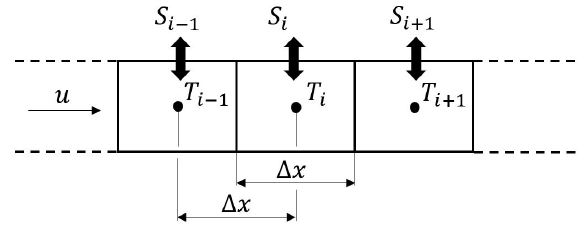
Figure 1. Division of pipe’s fluid region into volumes, with localized spatial dependent variables.